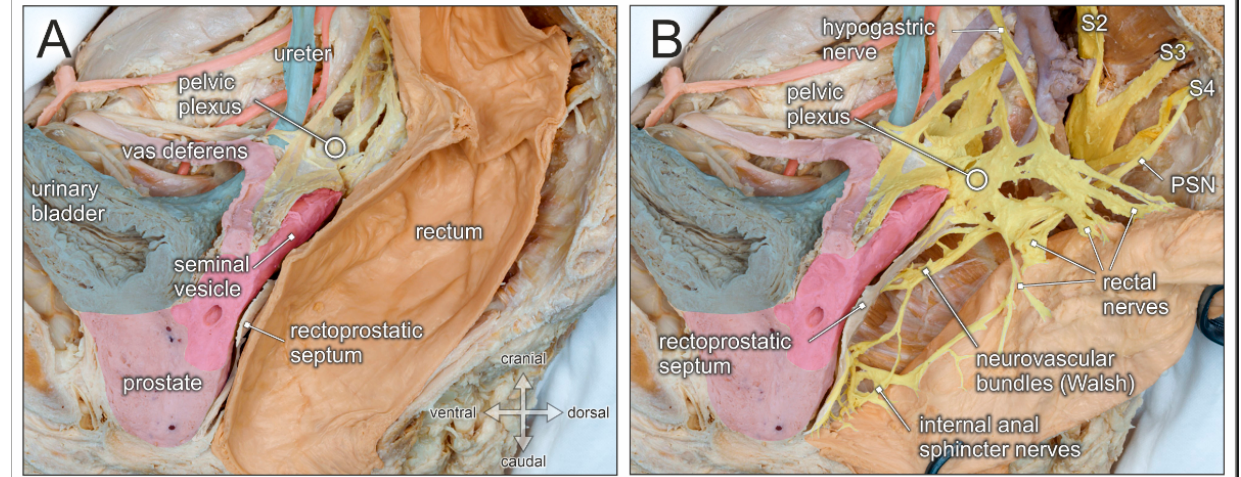
Figure 3. Topographic anatomy of the posterior pelvic compartment. Medial view of a right-sided male hemipelvis. The parietal pelvic fascia is removed to visualize the embedded autonomic pelvic nerves. ( A ) The posterior pelvic compartment is delimited from the urogenital compartment by the rectoprostatic septum (Denonvilliers fascia). ( B ) The rectum is pulled aside to reveal the inferior hypogastric/pelvic plexus, the hypogastric nerve, and the pelvic splanchnic nerves (PSN, from sacral nerve S4). The inferior hypogastric nerve gives rise to rectal nerves and more caudally to internal anal sphincter nerves, as well as the neurovascular bundle of Walsh.